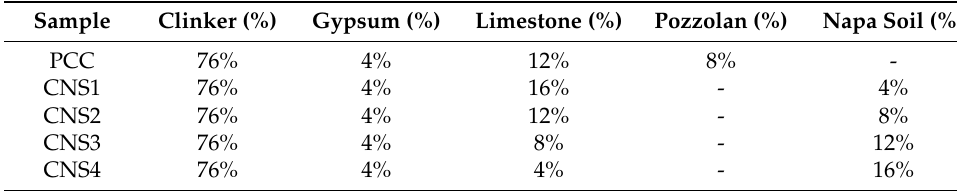
Table 1. The variation of materials in composite cement.